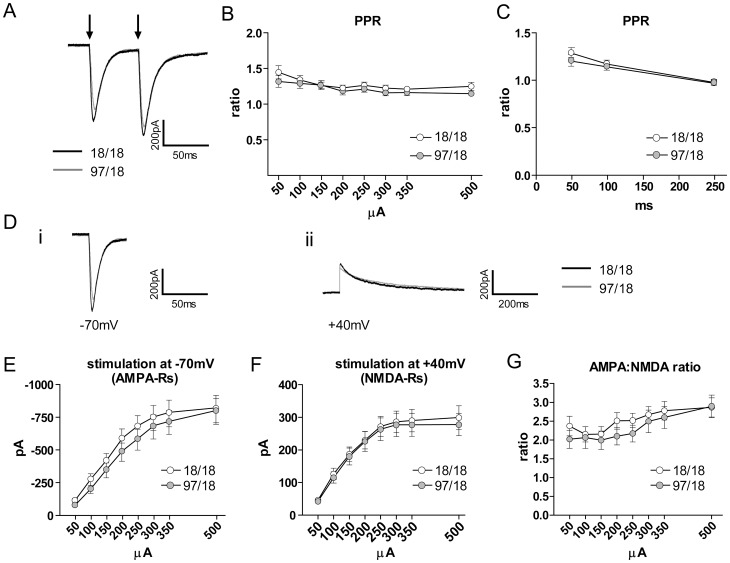
Paired-pulse ratio (PPR) and AMPA:NMDA ratio are not affected in Hu97/18 SPNs.SPNs were whole-cell patch-clamped at Vh = -70 mV with caesium-based internal solution to allow for better membrane voltage control. (A) Representative traces showing responses of Hu18/18 and Hu97/18 SPNs to 200 µA paired-pulse stimulation (marked with the arrows) with 50 ms interval. Stimulus artifacts were removed. (B–C) No difference between Hu18/18 and Hu97/18 SPNs in PPR with different stimulation intensities (50–500 µA; B) and different time of inter-stimulation intervals (50, 100 and 250 ms; C) implies no change in probability of release from excitatory presynaptic terminals. For the experiments in (B), Hu18/18 n = 22 and Hu97/18 n = 22; for the experiments in (C), Hu18/18 n = 11 and Hu97/18 n = 14. (D) Representative responses of Hu18/18 and Hu97/18 SPN to 200 µA stimulation at Vh = -70 mV (i), analysed as AMPA receptor response, and at Vh = +40 mV (ii), analysed as NMDA receptor response at 40 ms from the initial peak. Stimulus artifacts were removed. (E) There was no statistically significant difference in the response to the stimulation at Vh = -70 mV between Hu18/18 (n = 22) and Hu97/18 SPNs (n = 22). The trend towards a smaller response in Hu97/18 SPNs may suggest, however, a decreased number of synaptic AMPA receptors. (F) No difference in the response to the stimulation at Vh = +40 mV between Hu18/18 (n = 22) and Hu97/18 SPNs (n = 21) implies no change in NMDA receptor expression levels. (G) AMPA:NMDA ratios (measured as an average from the cells where both responses to the stimulation at Vh = -70 mV and Vh = +40 mV were recorded) showed no difference between Hu18/18 (n = 19) and Hu97/18 SPNs (n = 19).